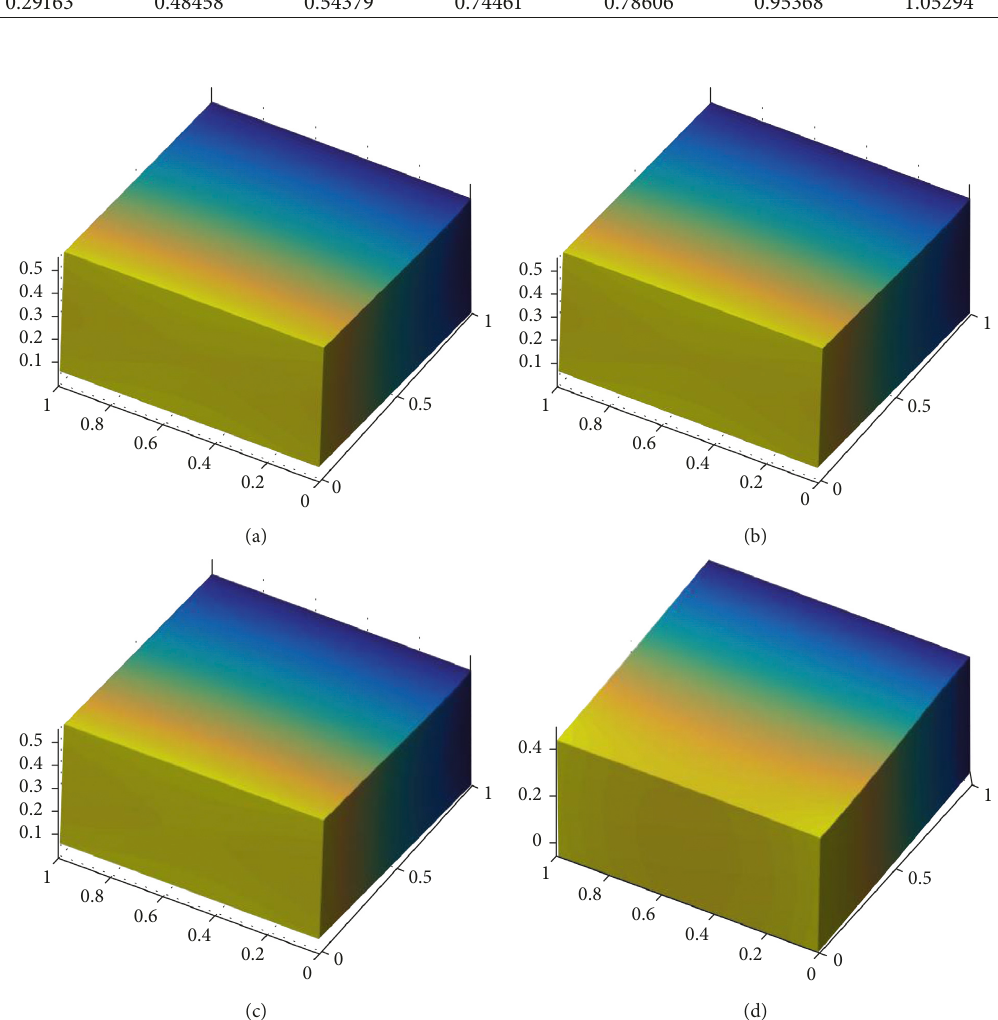
Figure 2: Mode shapes of the elastically supported plate elastically restrained in the x direction: (a) k (d) k u � 10 16